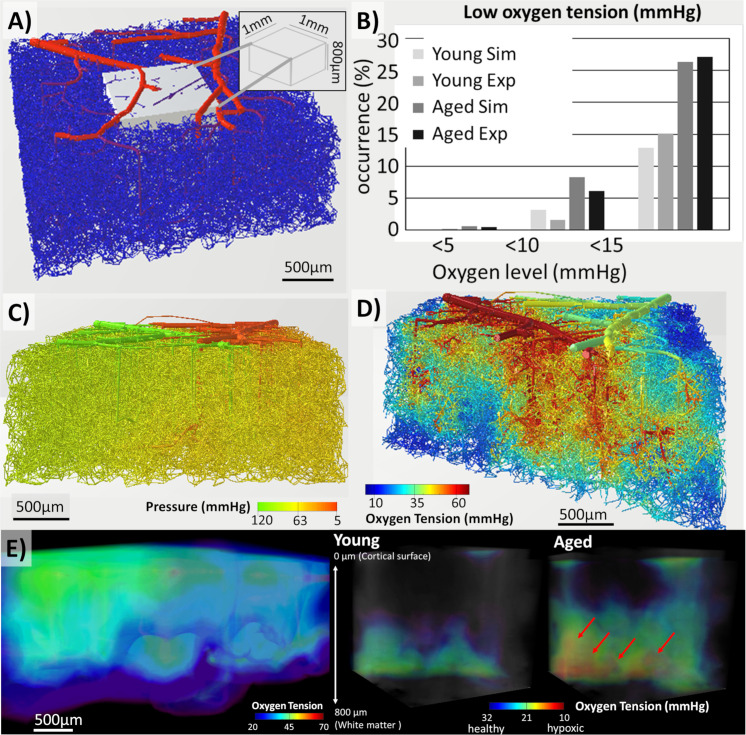
Comparison between oxygen tension in young mouse and aged mouse suffering from reduced hematocrit in a large size synthetic vascular network spanning 3x3x1.2mm3 of the mouse cortex.A) The vascular structure colored by diameter (red = thick, blue = thin) shows a dense set of tortuous vessels connected through a complete capillary bed. B) The tabulated occurrence rate of low-oxygen mesh elements in a portion (= a 1x1x0.8mm3 tissue subset from the interior of the domain) of the predicted oxygen field shows the same trends as in the experimental data. C) Predicted pressure distribution throughout the network matches the topology of arteries, veins, and capillary closure. D) A cut through the dense structure reveals regions of hypoxia and pockets of hypoxia occur more frequently in the lower regions of the cortex. D) A zoomed view of oxygen tension in the interior of the vascular network. There are some segments with low oxygen content (but above the hypoxic threshold) especially in deeper regions). E) The oxygen levels in the tissue reveal the lower regions are more susceptible to lower oxygen tension then regions near the cortical surface. A detailed view compares oxygen tension in young to aged specimen. In the young specimen, no hypoxic areas form. In the simulated age mouse, hypoxic regions and their spatial extent were identified; hypoxic pockets are indicated in red and are larger and more prevalent in the aged brain.